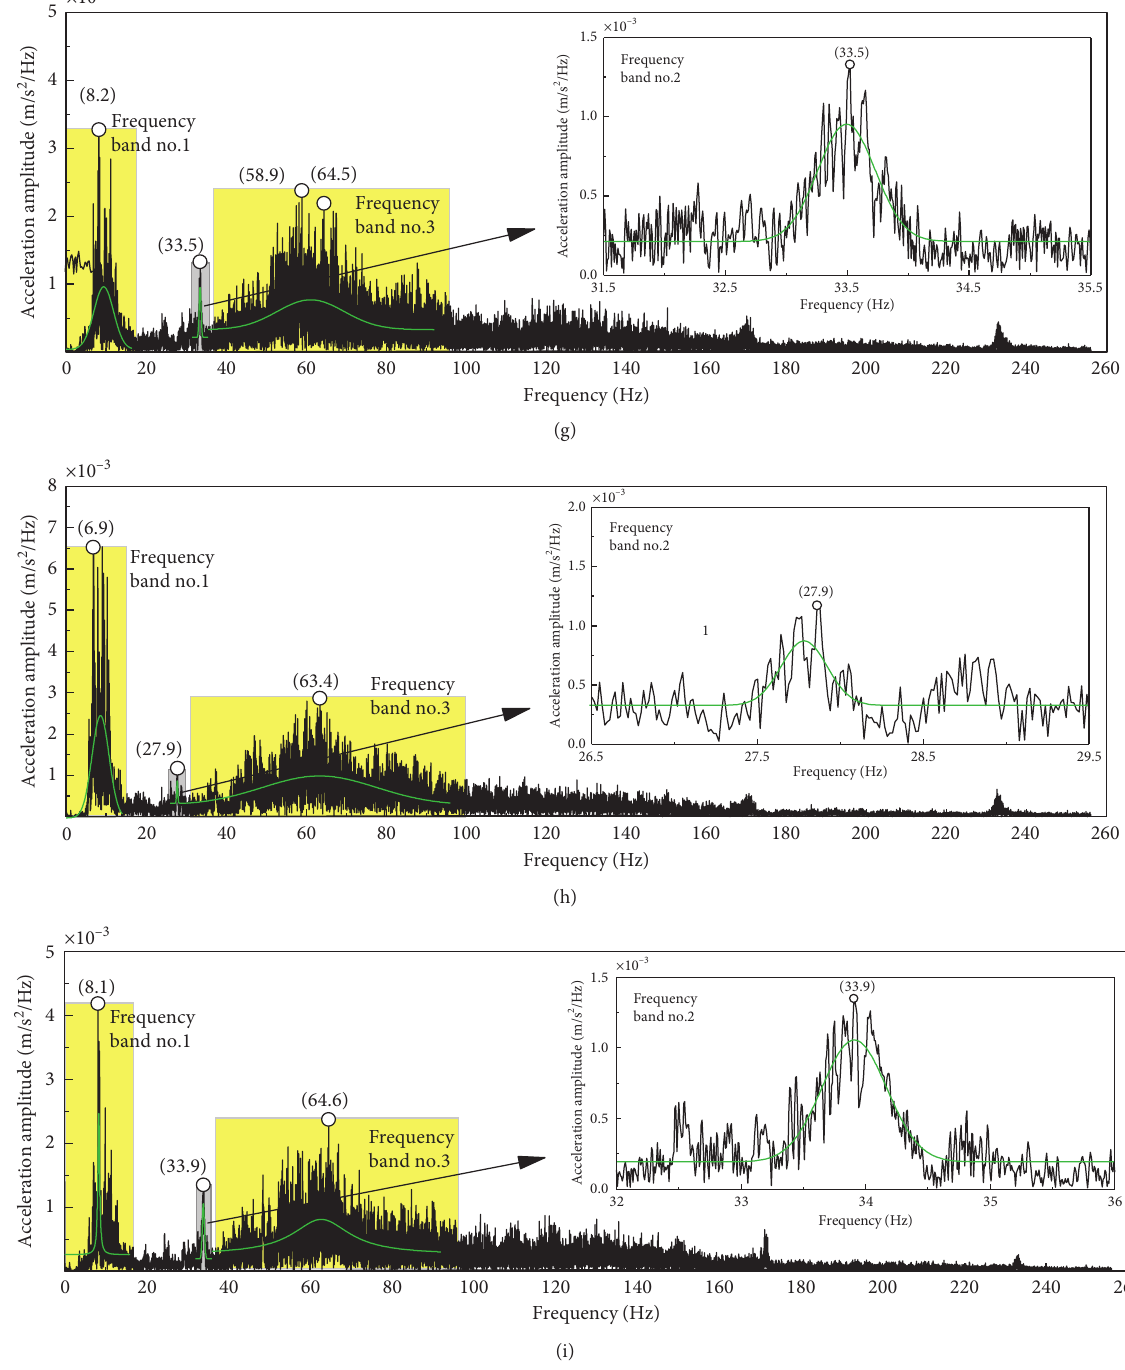
Figure 4: Frequency spectra of acceleration at P 4. (a) Freight train 11018. (b) Freight train 11404. (c) Freight train 11114. (d) Freight train 11138. (e) Freight train 40194. (f) Freight train 111040. (g) Freight train 11020. (h) Freight train 40196. (i) Freight train